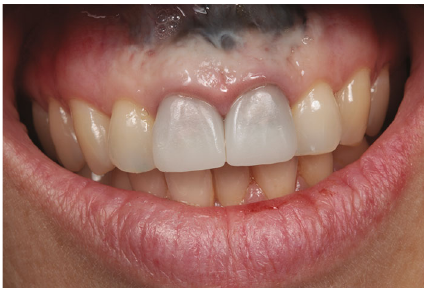
Figure 27: Fitting of the provisional crowns during four weeks to stabilize the surrounding gingival tissues.